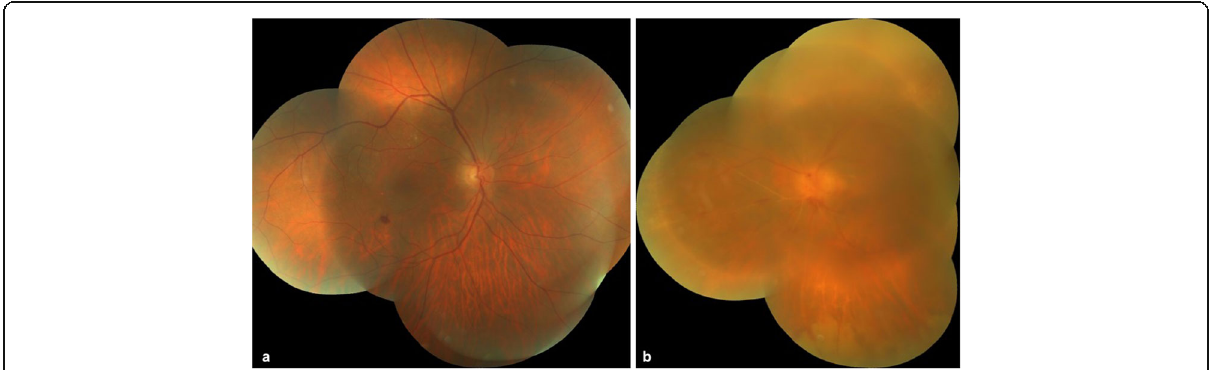
Fig. 4 a Color fundus photograph of the right eye showing the resolved area of retinal whitening with reduced disc edema. b Color fundus photograph of the left eye showing reduced vitritis, resolving tongue-shaped necrotizing retinitis yellowish ill-defined lesions beyond the arcades, attenuated arteries, sclerosed vessels, and reduced disc